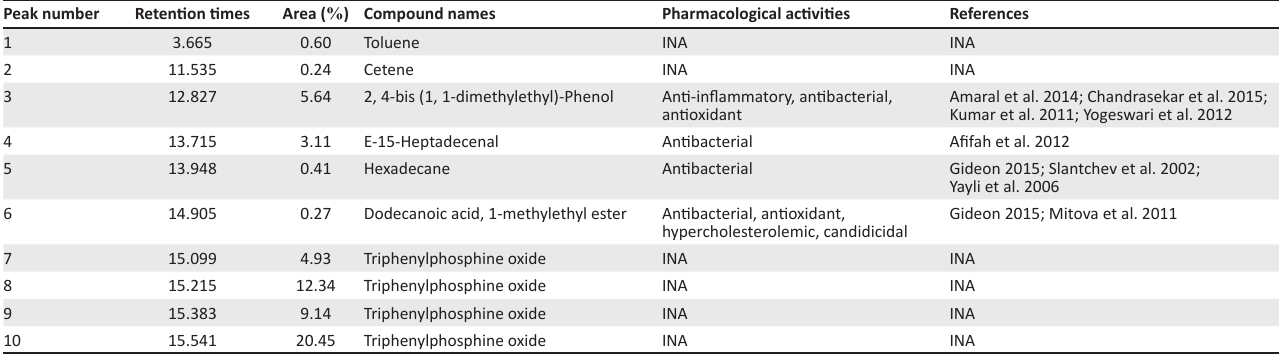
FIGURE 2: Mode of inhibition of α-glucosidase by aqueous extract of E. elephantina root revealing an uncompetitive inhibition. TABLE 4: Depicted phytoconstituents from gas chromatography-mass spectroscopy chromatogram of subfraction 4. Peak number Retention